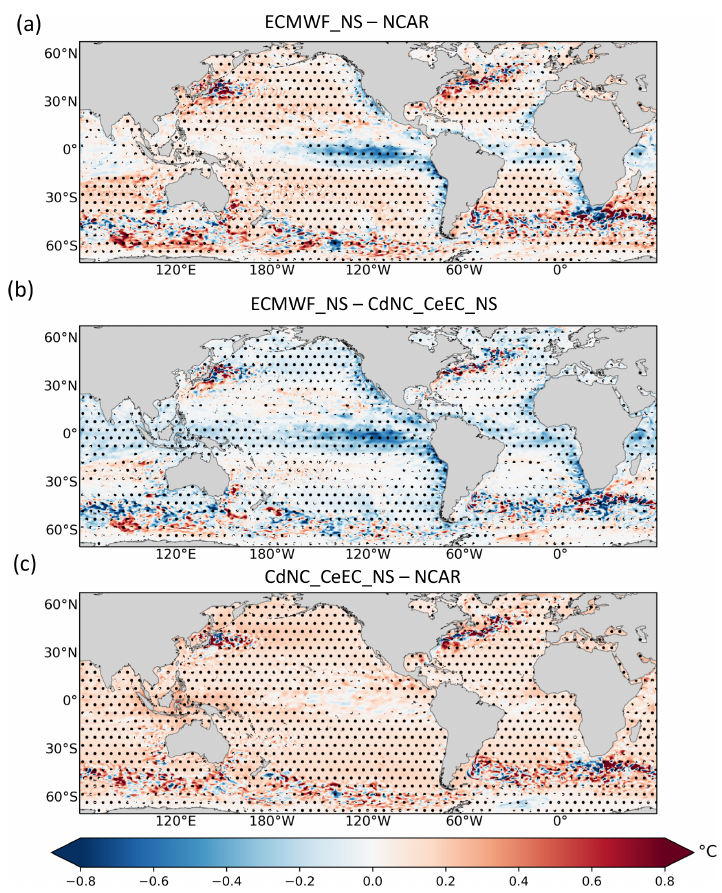
Figure 6. Annual mean SST differences: (a) ECMWF_NS − NCAR , (b) ECMWF_NS − CdNC_CeEC_NS , and (c) CdNC_CeEC_NS − NCAR . Hatching indicates significant values (95% confidence